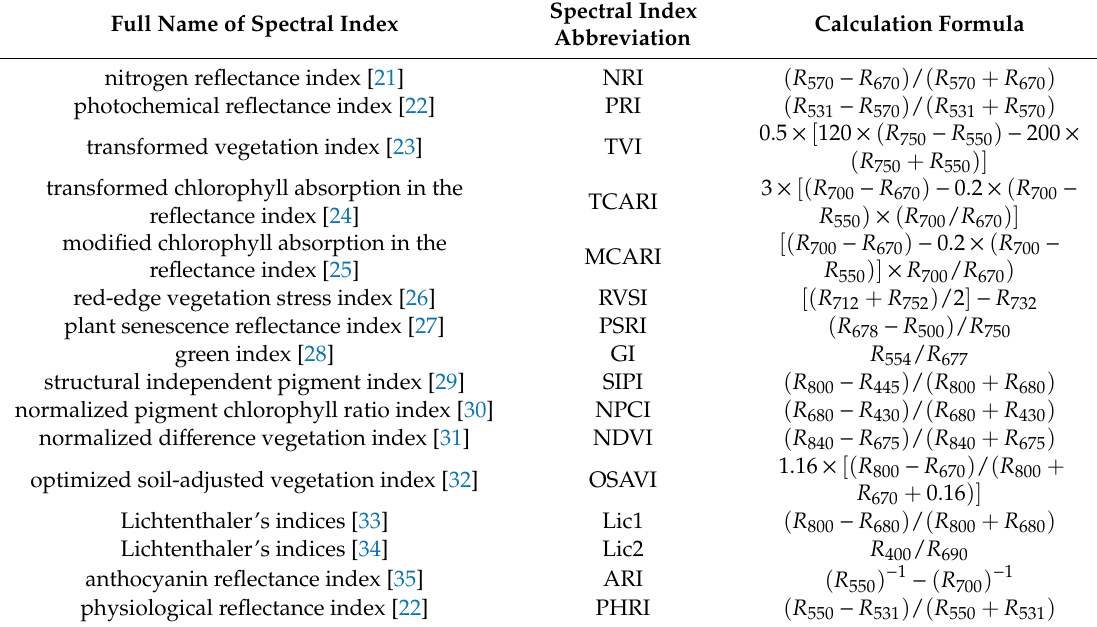
Table 1. Traditional spectral indices tested in the